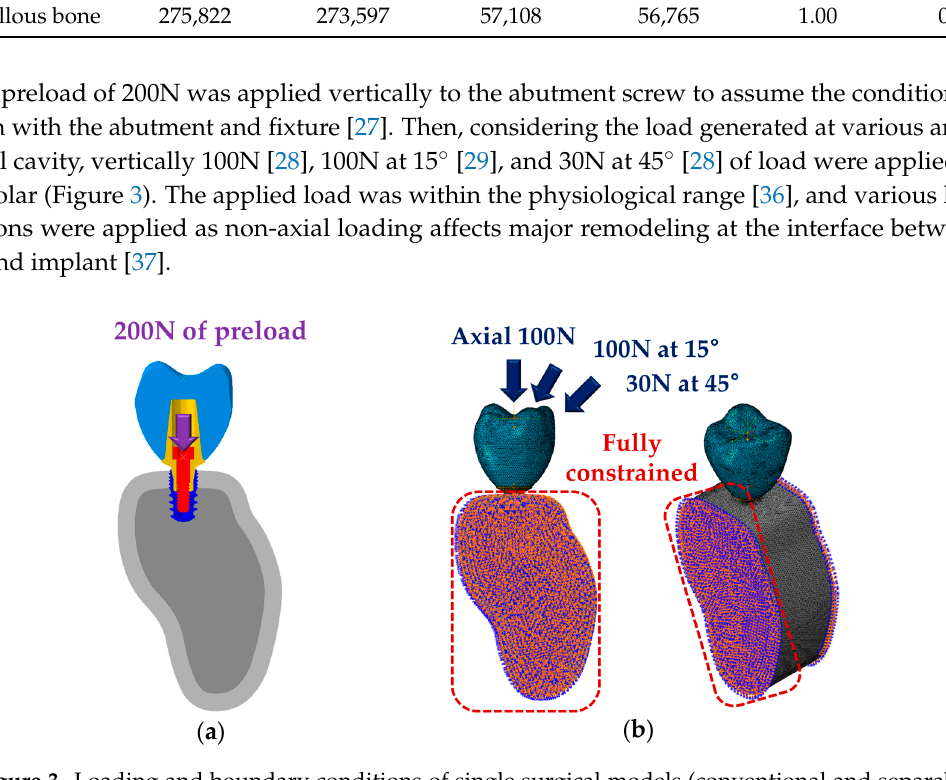
Table 2. Number of elements and nodes for finite element surgical model.